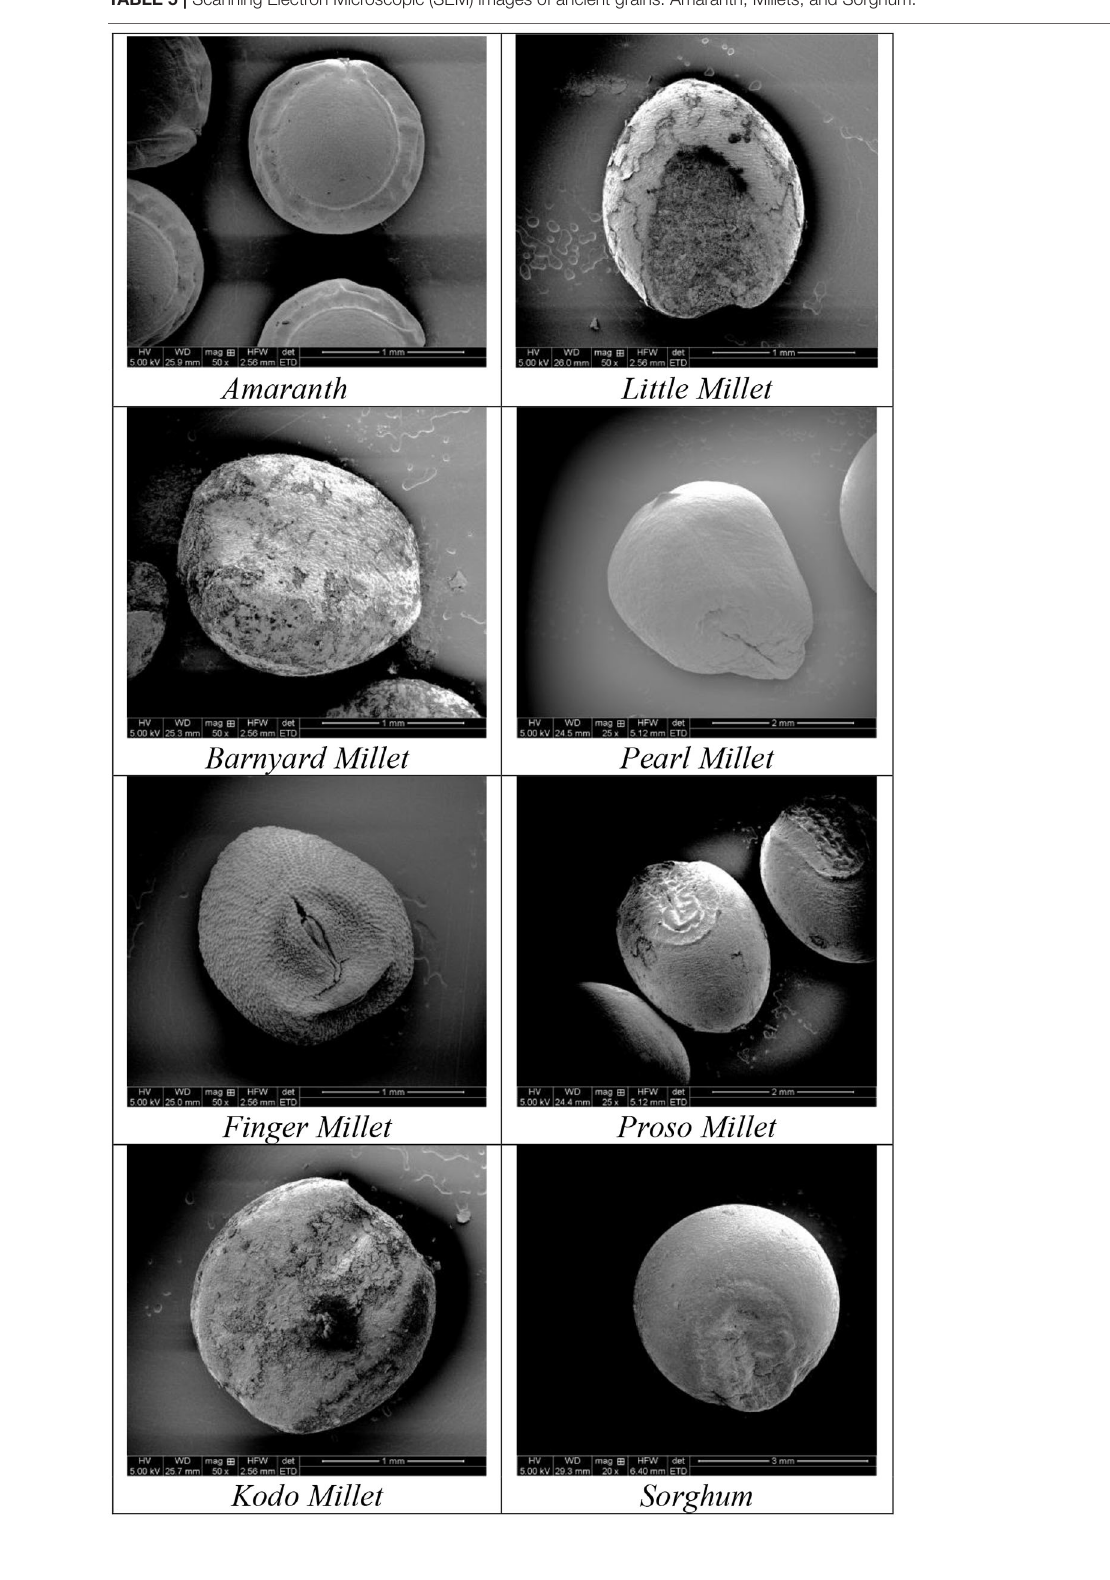
Frontiers in Sustainable Food Systems |